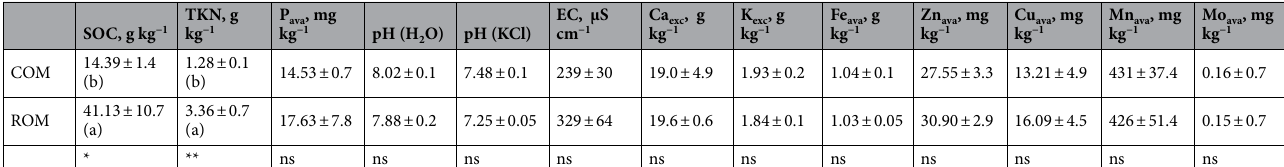
Table 2. Chemical properties (mean ± standard deviation of three replicates) of Locone Lake soils. COM control soil; ROM Robinia pseaudoacacia L. soil, SOC soil organic carbon, TKN total kjeldahl nitrogen, Ava available, EC electrical conductivity, Exc exchangeable. The values in each column followed by a different letter are significantly different according to HSD test. *Significant at p ≤ 0.05; **significant at p ≤ 0.01; ns not significant.